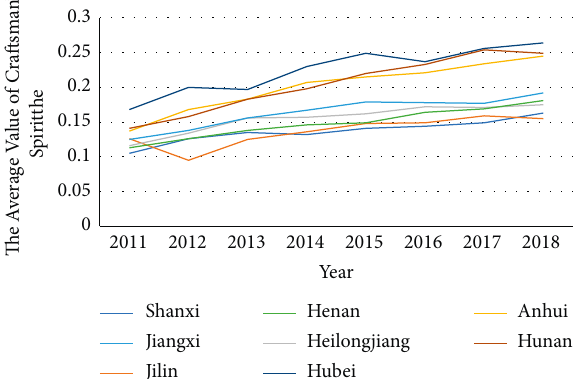
Figure 4: The trend of the average value of craftsman’s spirit in the construction industry in the central region from 2011 to